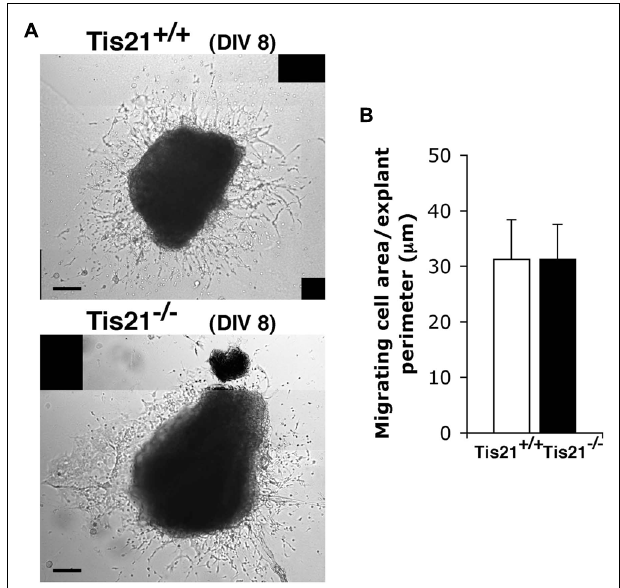
FIGURE 7 | Tis21 deletion does not affect the intrinsic migration of neurons from SVZ explants. (A) Neuroblast migration from SVZ explants isolated from P60 Tis21 -knockout and wild-type mice at 8 days (8 DIV) of the culture.The bright regions surrounding the explants in representative phase-contrast images are formed by cells that have migrated out. (B) Quantification of the migration of neuroblasts from SVZ explants ( n = 3 mice for each genotype).The migration was quantified by measuring the area of the bright region around the explant, visible in (A) , after normalization to the perimeter of the explant. Scale bar 100 μ